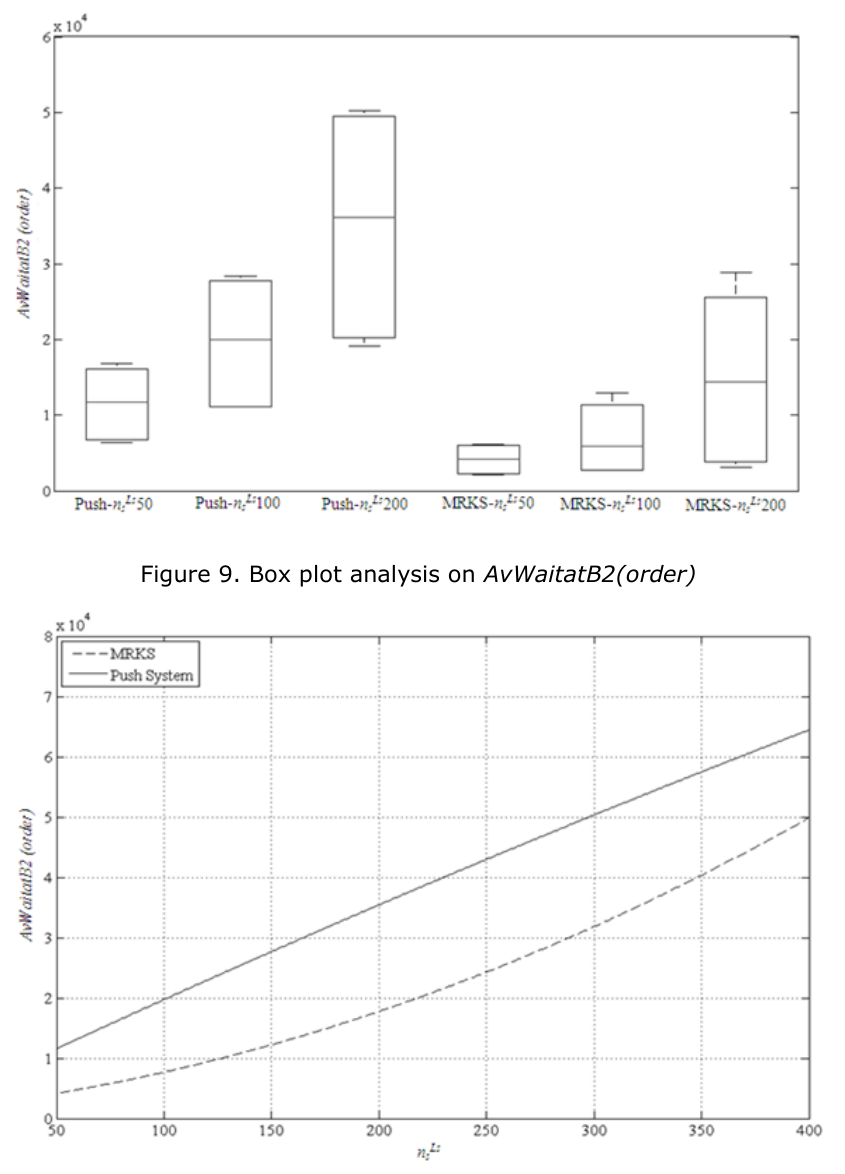
Figure 10 . Effect of n sLs on